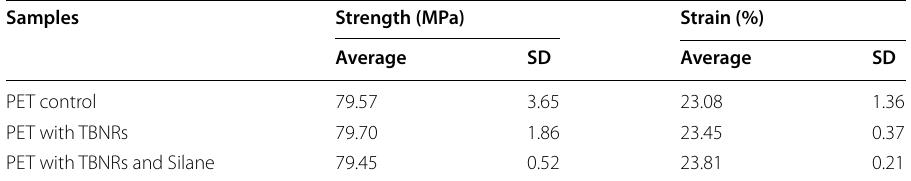
Table 2 Mechanical properties of PET (control, tungsten bronze nanorods (TBNRs), TBNRs and silane) Samples Strength (MPa) Strain (%) Average SD Average SD PET control 79.57 3.65 23.08 1.36 PET with TBNRs 79.70 1.86 23.45 0.37 PET with TBNRs and Silane 79.45 0.52 23.81